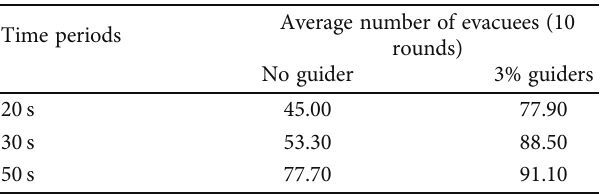
Figure 4: Average number of evacuees of ten trial runs of 100 individuals with 0% and 3% guiders in simulations. Evacuation time period is set to 50 s. The simulation domains is a room with one and two exits as Figure 3. The smoke source is placed in the middle of the room. Table 3: Average number of evacuees of ten trial runs of 100 individuals with 0% and 3 % guiders in simulations. Evacuation time periods are set to 20, 30, and 50s. The simulation domain is a room with two exits as Figure